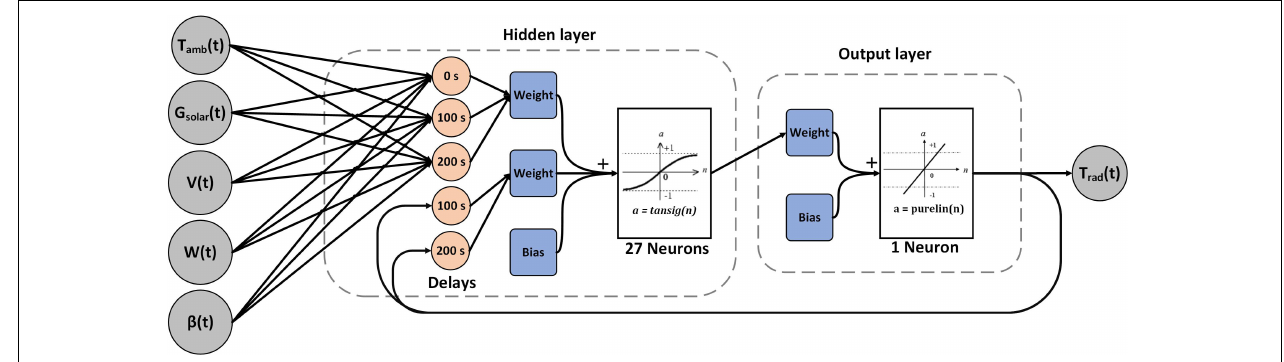
FIGURE 4 | Structure of the NARX neural network for predicting the temperature of the system and water.